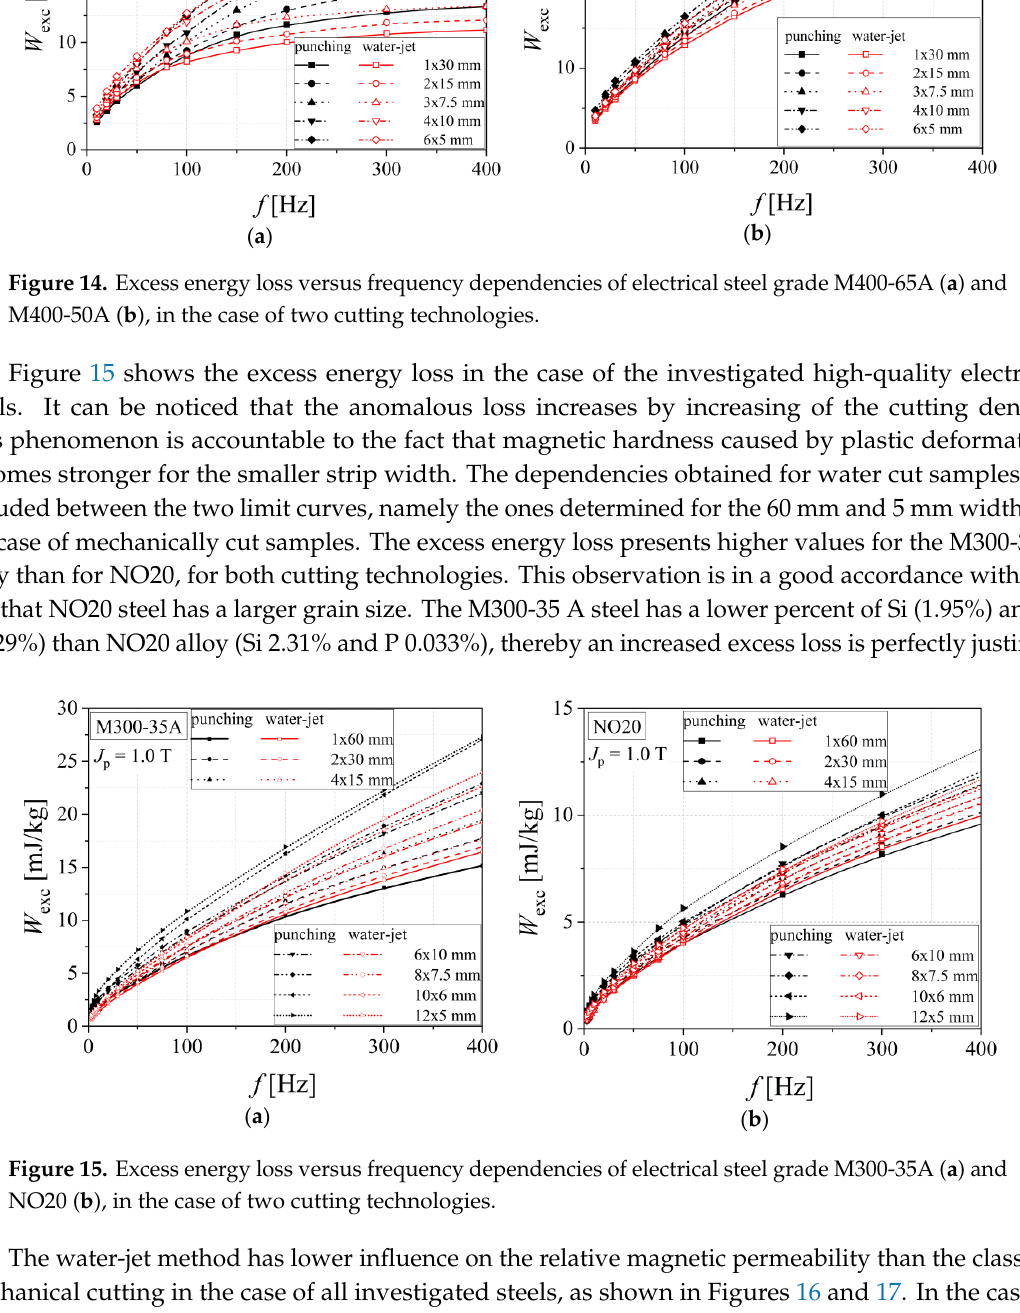
( b ) Figure 16. Relative magnetic permeability versus frequency dependencies of electrical steel grade M400-65A ( a ) and M400-50A ( b ), in the case of two cutting technologies.